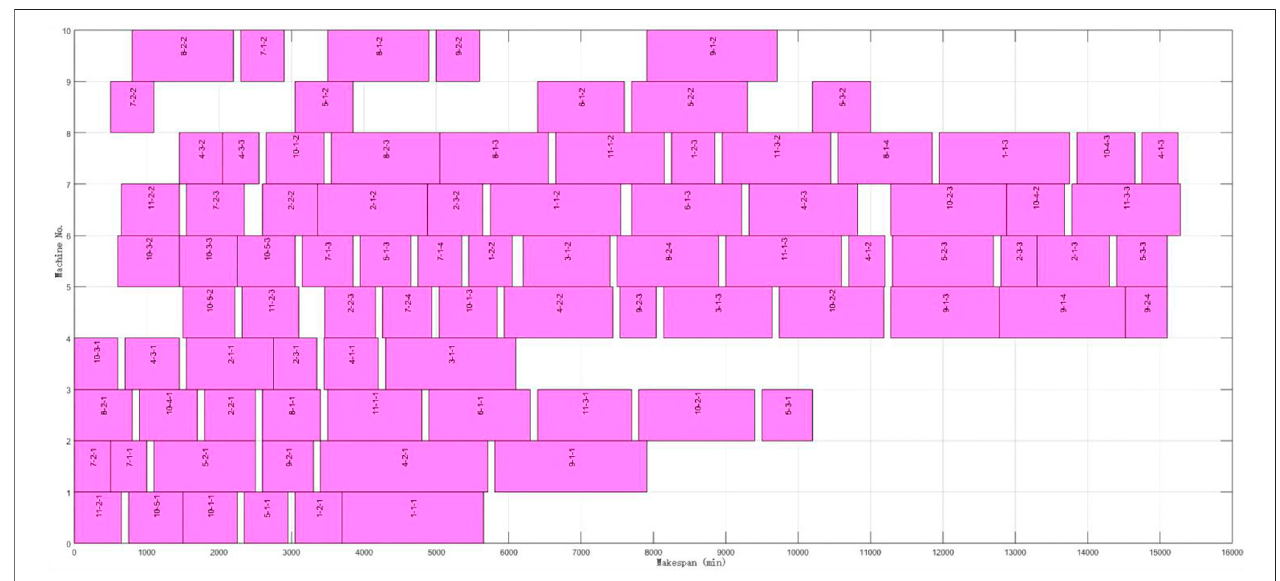
FIGURE 10 | Gantt chart of lot-splitting scheduling with assembly constraints.